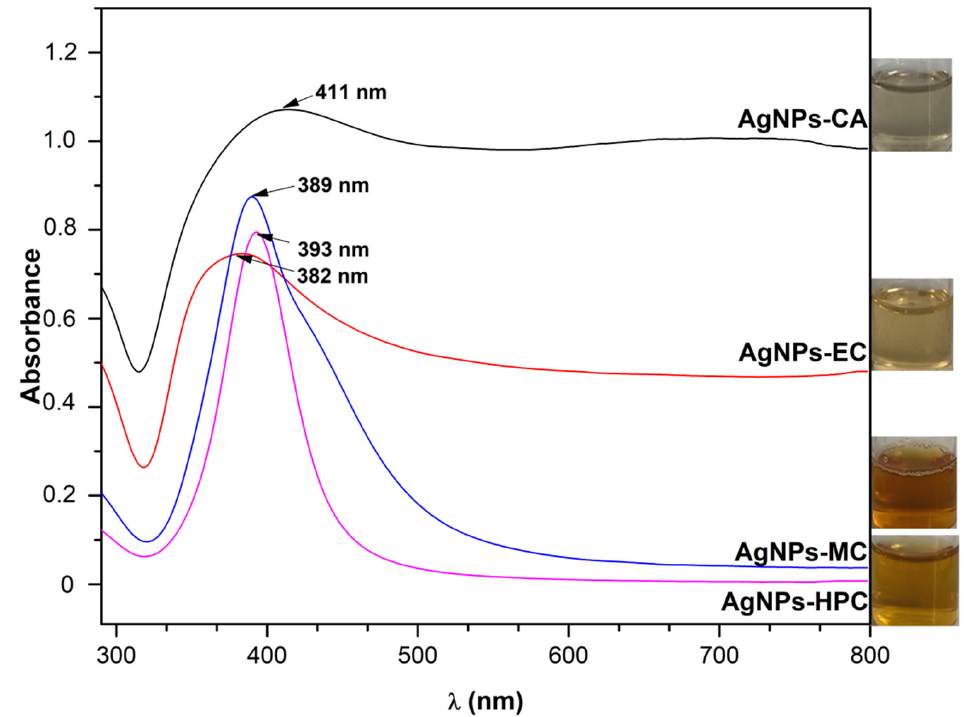
Figure 3. UV-Vis spectra of AgNPs synthesized from cellulose derivatives (CA—cellulose acetate,